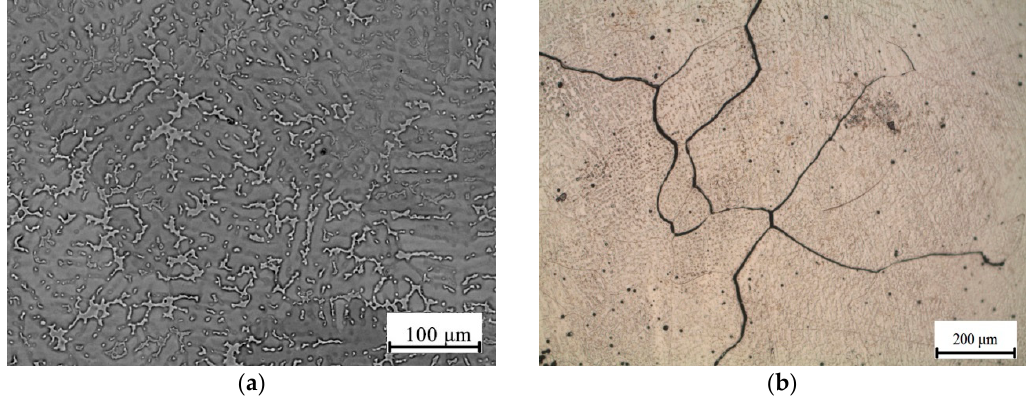
Figure 9. Microstructure of reference alloy Al10Mg: ( a ) as-cast, SEM ( b ) solution treatment at 440 °C, 3 h, water quenching and aging at 200 °C, 3 h, OM.